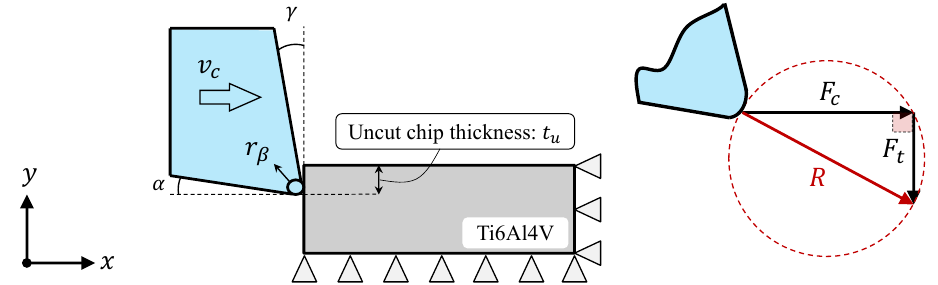
Figure 4. Configuration of orthogonal metal cutting problem and a closeup of the force